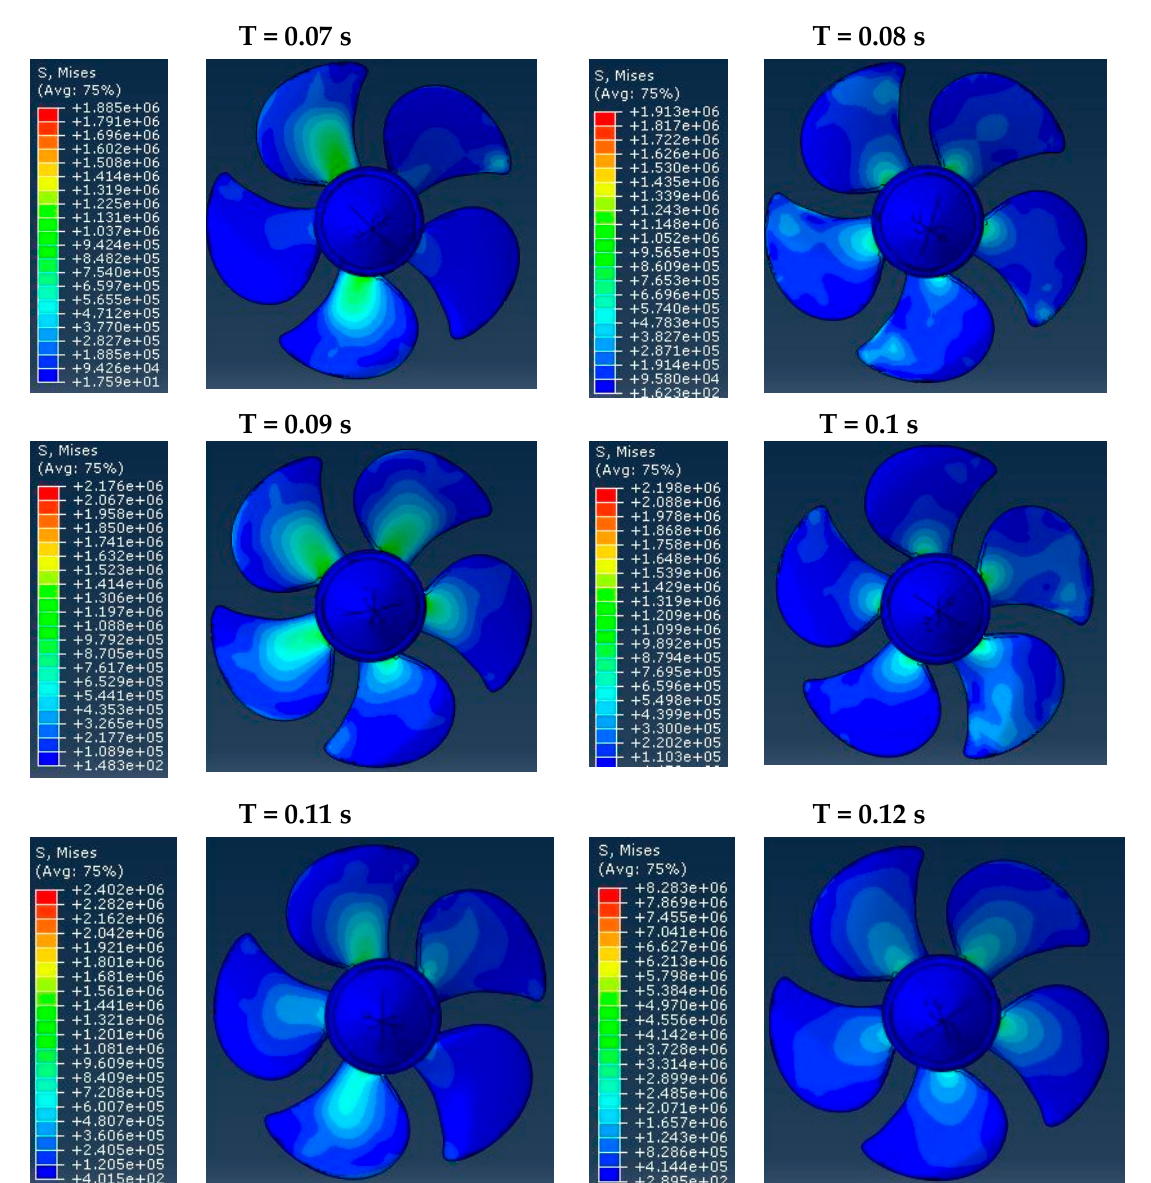
Figure 11. Von Mises stress evaluation on propeller surface at different time-steps.